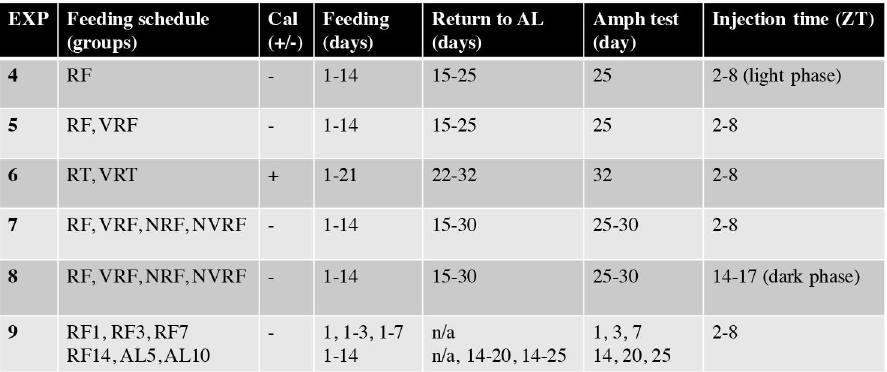
Fig 3. Exps 4–9: protocol timelines for testing feeding schedule cross-sensitization to AMPH. In experiments 4–8, different feedingscheduleswere tested for cross-sensitization to AMPH 10–15 days after returningto free access feeding(ad libitum, AL). In experiment9, cross-sensitization of RF was tested on days 1, 3, 7 or 14 of RF (RF1, RF3, RF7, RF14) and at 5 or 10 into ad libitum feedingfollowing2 weeks of RF (AL5, AL10). The use of caloric (cal) restriction or surplus by experimental design are indicatedwith—or +, respectively. CTRL rats had no changesto diet and were tested on the same day as feedinggroups. Experiment 4 also includeda saline injectionsubgroupas a second control group on AMPH test day. All injections occurredbetween ZT 2–8, the time of day correspondingto FAA in RF rats, with the exception of experiment 8 where injectionsoccurredbetweenZT 14–17,correspondingto FAA for NRF rats. Feeding group abbreviations: RF = restricted feeding, VRF = variableRF, RT = restricted treat, VRT = variableRT, NRF = night RF, NVRF = night VRF, CTRL =